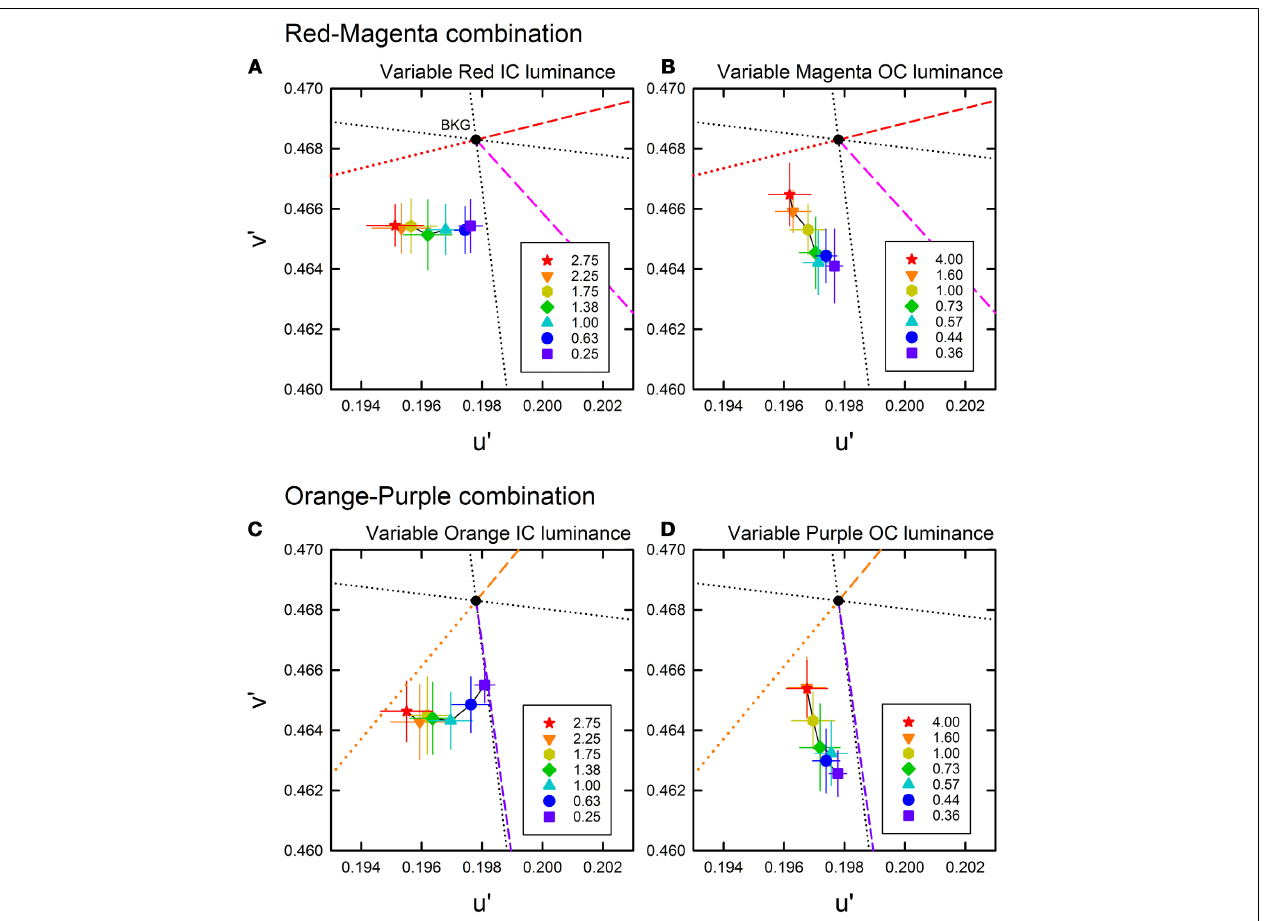
FIGURE 2 | Color cancelation data of Experiment 1 plotted in the CIE u (cid:2) v (cid:2) chromaticity diagram. (A,B) The results for a red inner contour (IC) and magenta outer contour (OC) combination, and (C,D) the results for an orange IC and purple OC combination. For each color combination, the left panel (A,C) shows the results obtained when the IC luminance was varied and the OC luminance was fixed to 20cd/m 2 , while the right panel (B,D) shows the results when the IC luminance was fixed to 20cd/m 2 and the OC luminance was varied (see also Table 1 ). Different symbols designate the mean chromaticity coordinates required to cancel chromatic induction for different IC/OC luminance ratios as shown in the legend. Error bars show ± 1 s.e.m. across